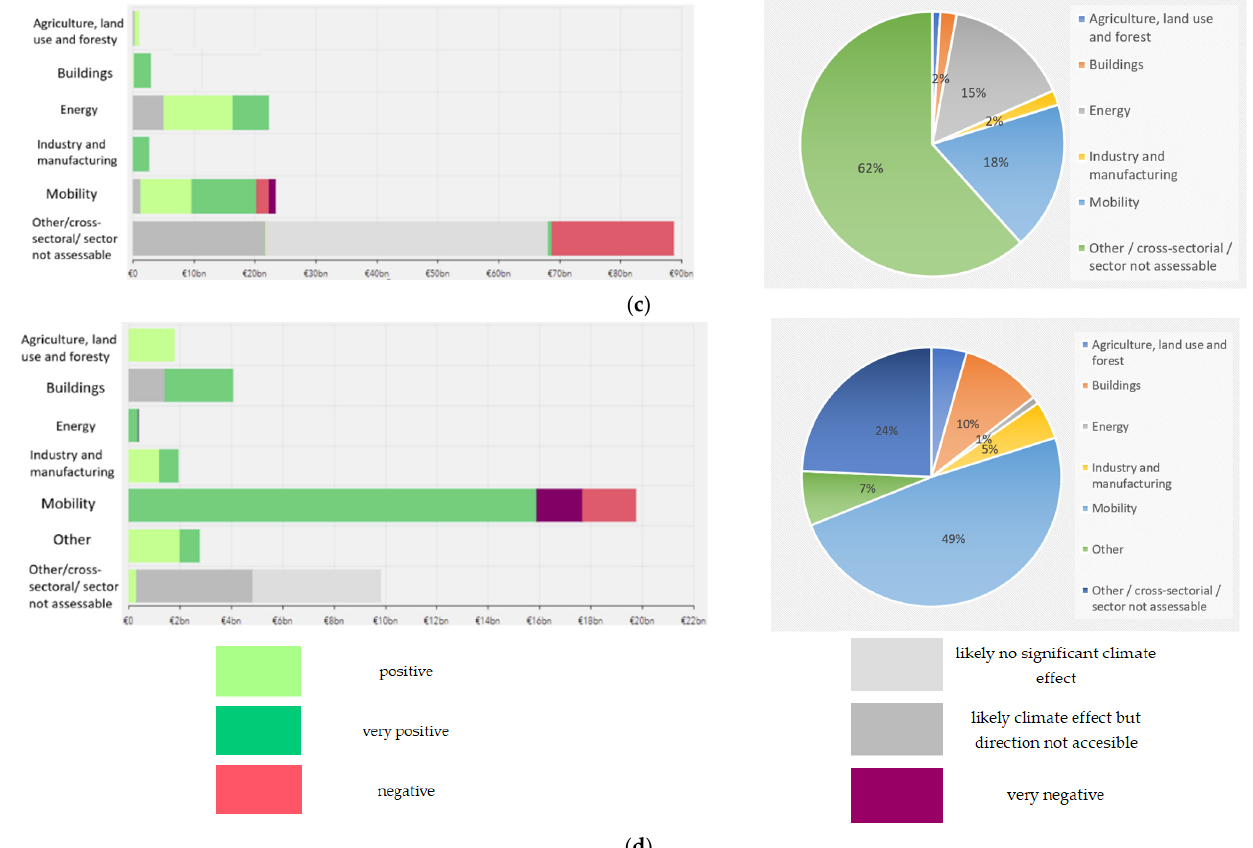
Figure 3. Comparison of some European Recovery Plans. ( a ) Spain; ( b ) France; ( c ) Germany; ( d ) Portugal. Source: own elaboration with data from the Green Recovery Tracker, E3G and the Wuppertal Institute [53–58]. 50.060.070.080.0 0.010.020.030.040.0